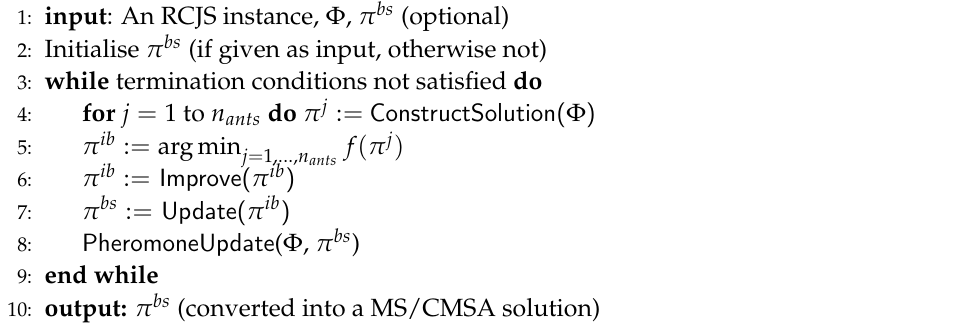
Algorithm 3 ACO for the RCJS